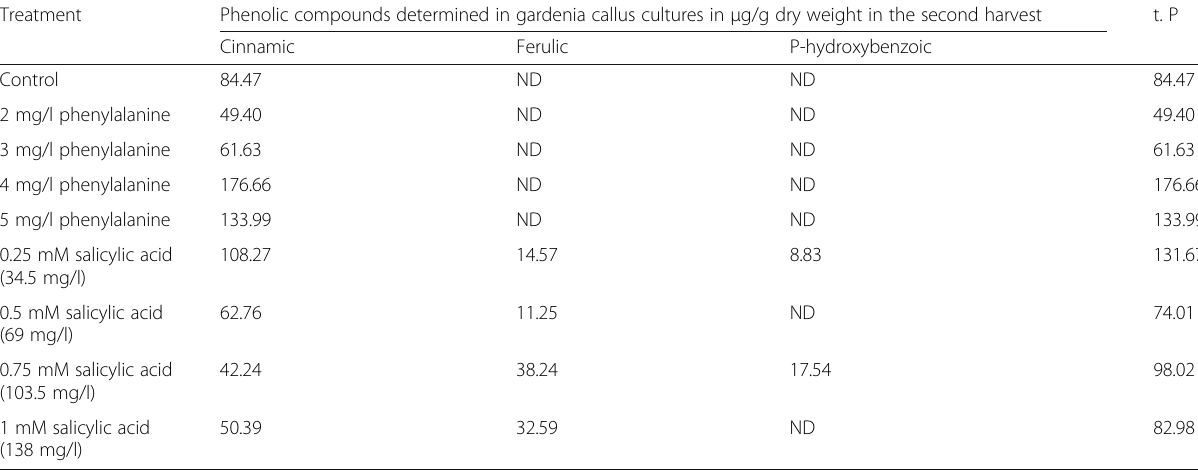
Table 6 Phenolic compound determination in gardenia calli cultures cultured on MS media contained different concentrations of phenyl alanine or salicylic acid during the second harvested period of culturing by HPLC Treatment Phenolic compounds determined in gardenia callus cultures in μ g/g dry weight in the second harvest